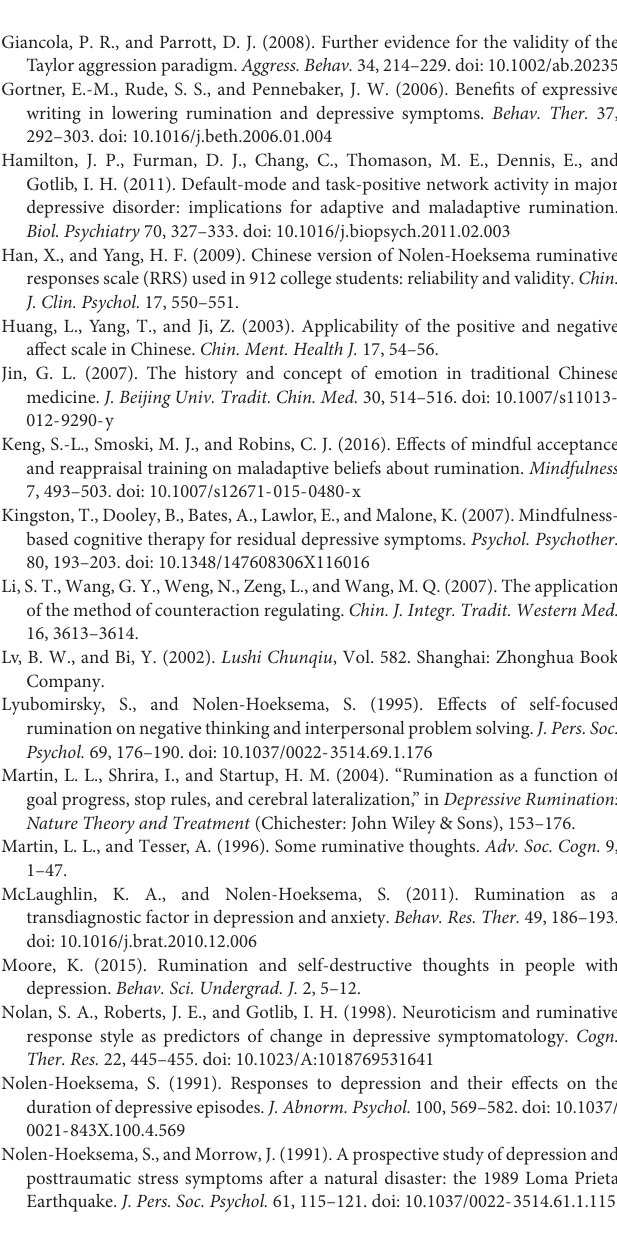
FIGURE S1 | The spss output of the correlation analysis of ruminative emotion and